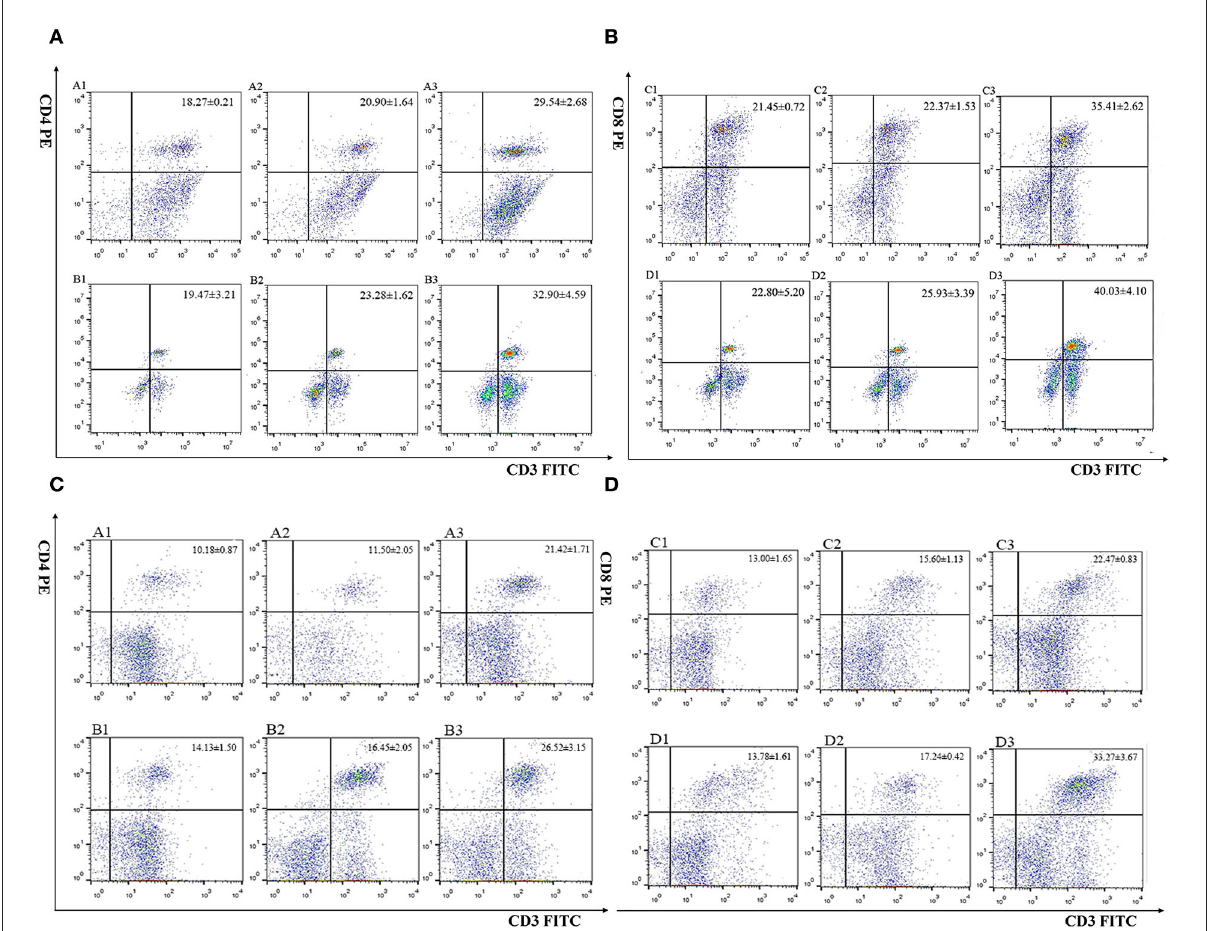
FIGURE4 Flow cytometric analysis of splenic CD4 + /CD3 + and CD8 + /CD3 + T lymphocytes. (A, B) Percentage of T cell subpopulation in the spleen of rEmROM1 immunized chickens. (C, D) Percentage of T cell subpopulation in the spleen of pEmROM1 immunized chickens. (A) Quantification of CD4 + /CD3 + lymphocytes in the chicken spleen at 21 days old (7 days after primary immunization). (B) Quantification of CD4 + /CD3 + lymphocytes in the chicken spleen at 28 days old (7 days after booster immunization). (C) Quantification of CD8 + /CD3 + lymphocytes in chicken spleen at 21 days old (7 days after primary immunization). (D) Quantification of CD8 + /CD3 + lymphocytes in the chicken spleen at 28 days old (7 days after booster immunization). 1: PBS (negative control). 2: Quantification of T lymphocytes with immunized pET-32a tag protein or pVAX1.0 plasmid. 3: Quantification of T lymphocytes with immunized rEmROM1 or